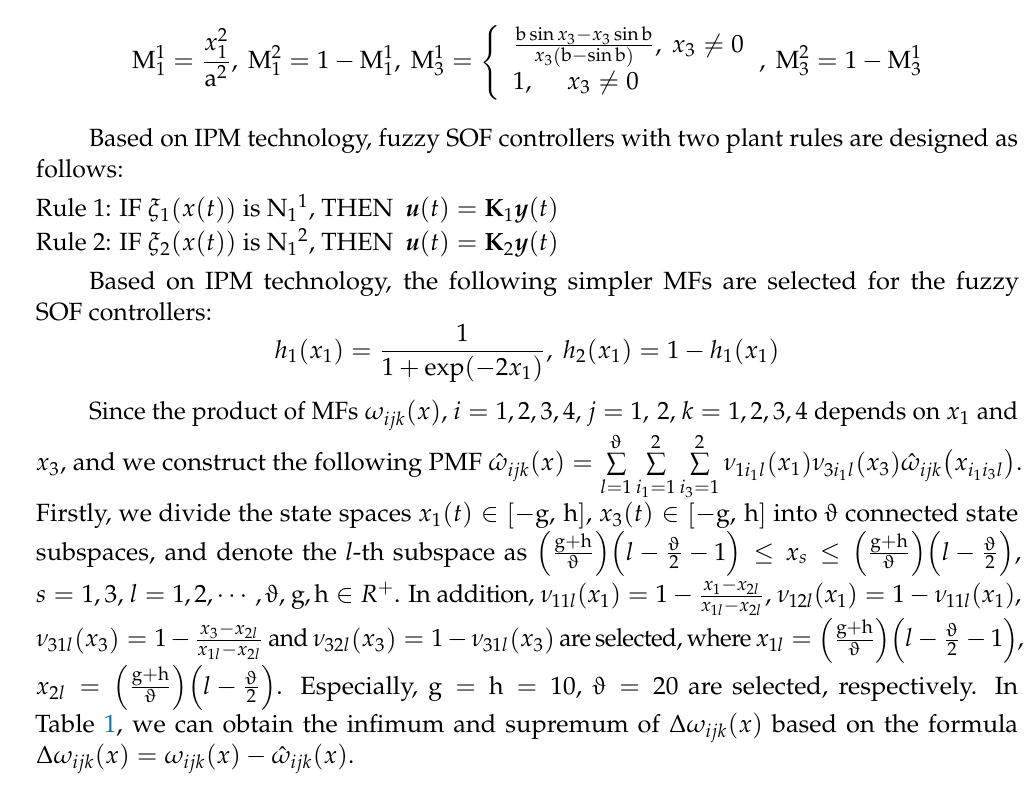
Table 1. The infimum and supremum of ∆ ω ijk ( x ) with ϑ =